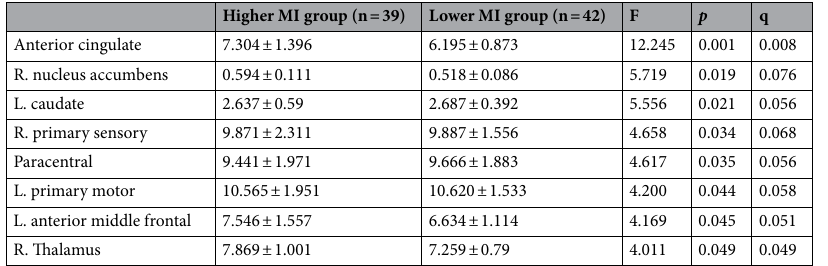
Table 3. Comparison of regional brain volume between the higher and lower MI groups; areas with significant differences are listed. Values reported as mean ± SD. MI, motor improvement; R, right; L, left.